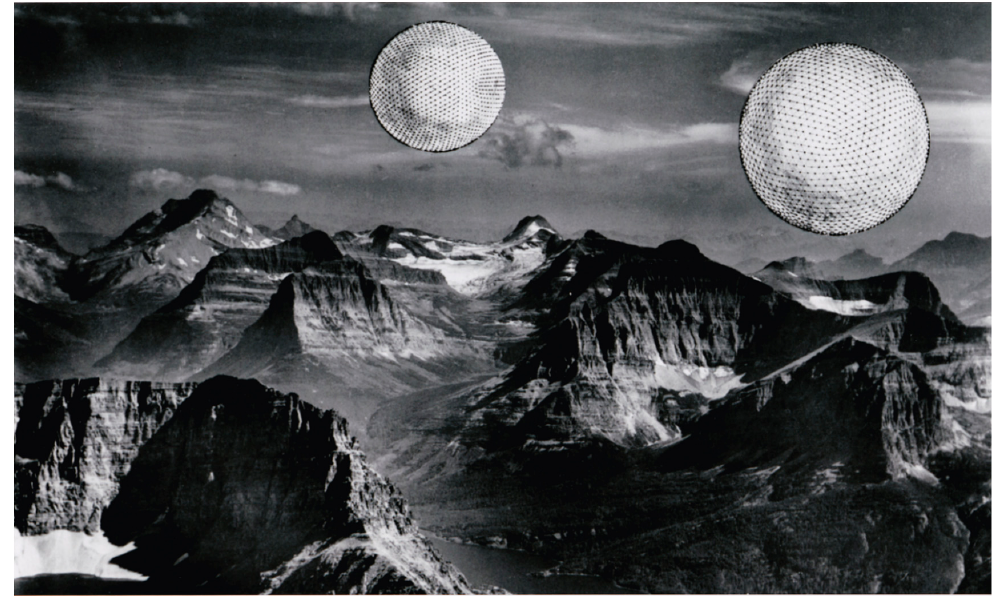
Figure 5. Buckminster R. Fuller and Shoji Sadao, Cloud No. 6, 1962. Collage. Courtesy the Estate of R. Buckminster Fuller.